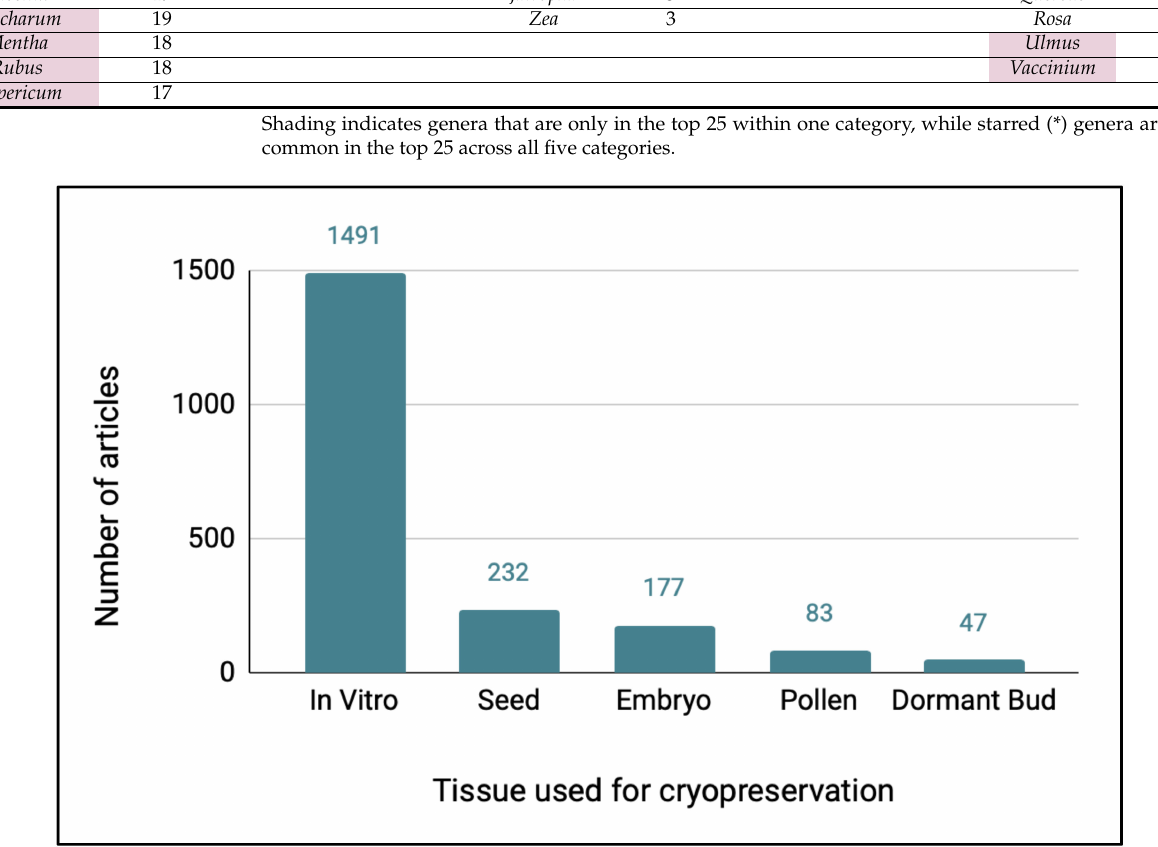
Figure 2. Number of Web of Science articles identified in each of the five categories of plant cryop- reservation research, separated by the type of tissue used in the study.